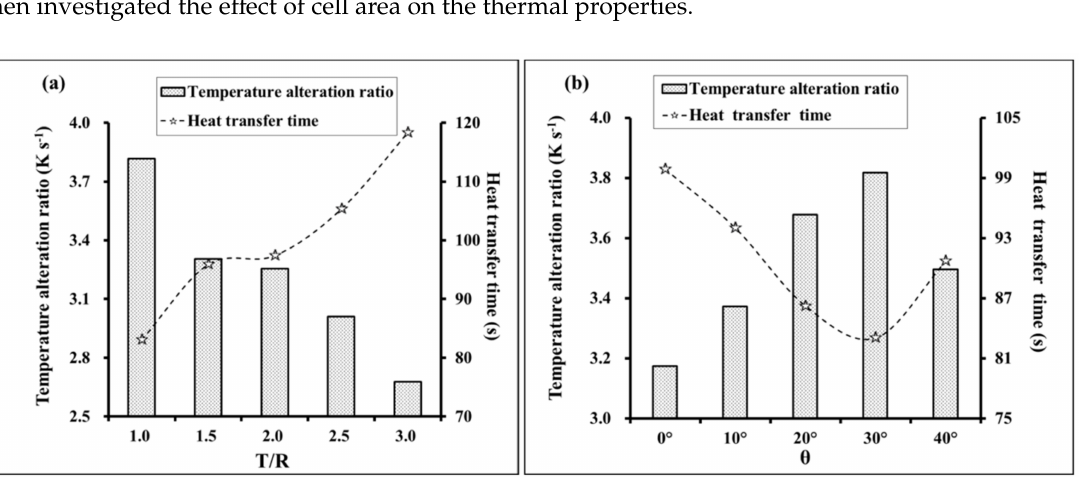
Figure 11. Influence of the cell geometries on the TAR (temperature alteration ratio) and heat transfer time, ( a ) influence of the ratio T / R; ( b ) influence of the angle θ